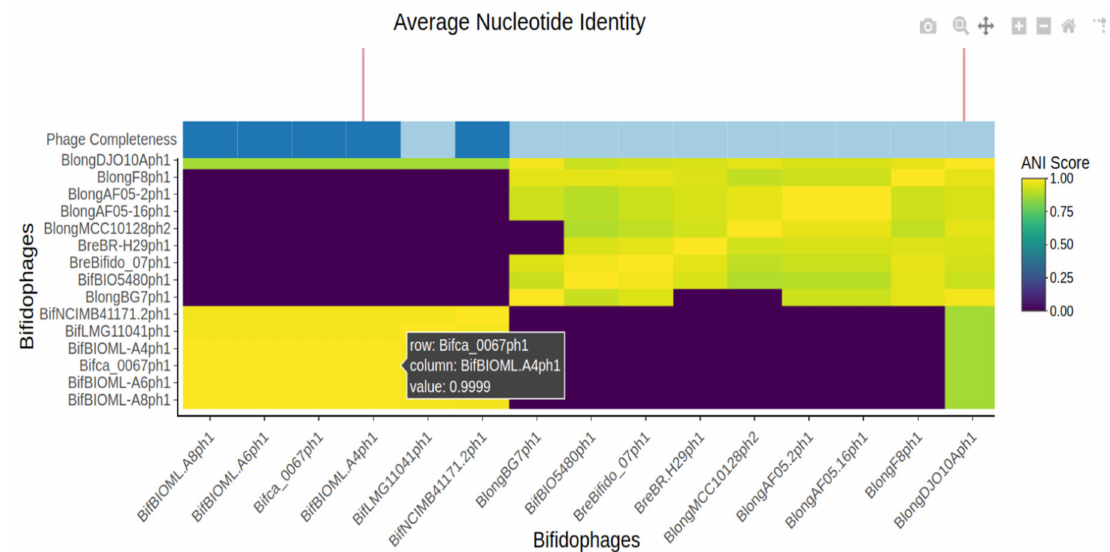
Figure 2. Interactive elements of ANI heatmap produced by heatmaply. Each cell can be highlighted to display the ANI value and the associated bifidophages. Representation of the lowermost left cluster in Figure 1 showing high intra-species ANI of a prophage-like region across several Bifidobacterium bifidum strains. Notably, five of the six regions were annotated as “likely complete” prophages by